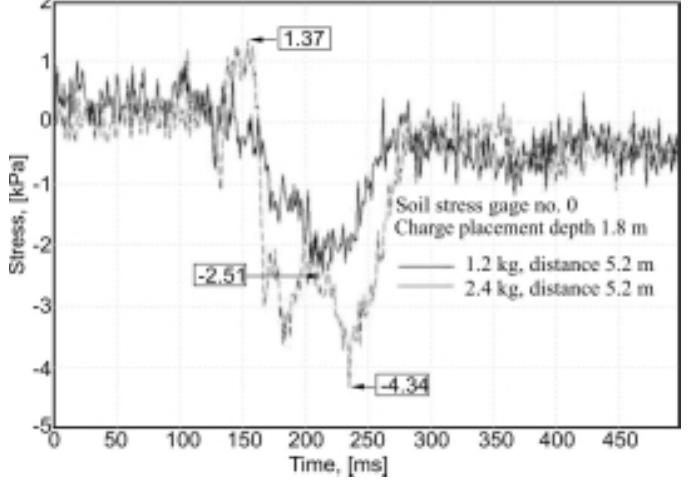
Fig. 8. Soil stress time histories σ h measured by gage No. 0 with the